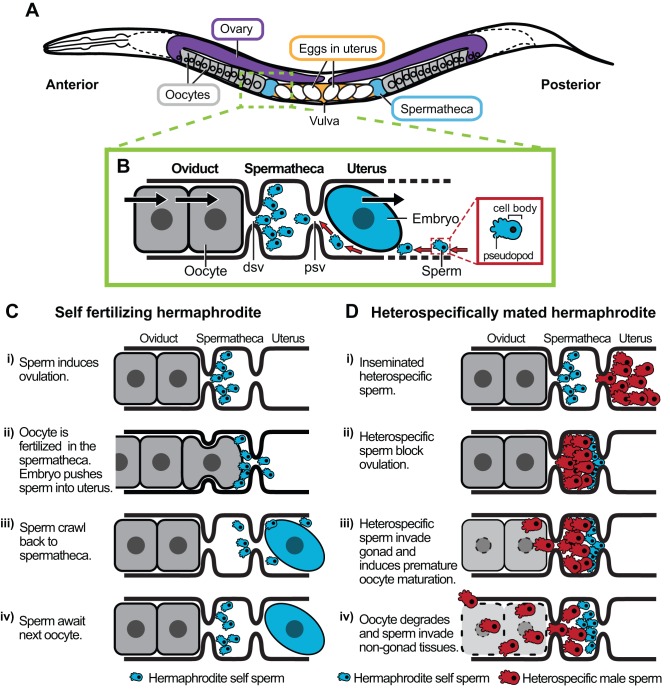
Graphical representation of a model for gametic isolation in Caenorhabditis.(A) Diagram of the reproductive tract of a XX nematode animal, magnified in (B) to illustrate the typical movement of gametes near the site of fertilization. Sperm must repeatedly crawl from the uterus to the spermatheca via the proximal spermathecal valve (psv) after being pushed out by fertilized eggs, migrating toward attractants secreted by the most proximal oocytes; red arrows indicate direction of sperm movement. Oocytes in the oviduct enter the spermatheca through the distal spermathecal valve (dsv) to be fertilized, then move into the uterus and exit the animal through the vulva; black arrows indicate direction of oocyte and embryo movement. (C) The normal process of self-fertilization in hermaphrodites (adapted from [64]) becomes disrupted upon heterospecific mating. (D) Heterospecific male sperm inhibit ovulation, invade the proximal gonad, induce premature oocyte maturation and ectopic fertilization, and in some cases invade somatic tissues.